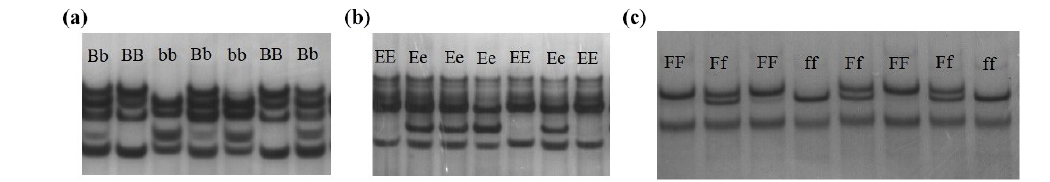
Figure 1. SSCP analysis of PCR amplification with three primers in Jinghai Yellow chicken.